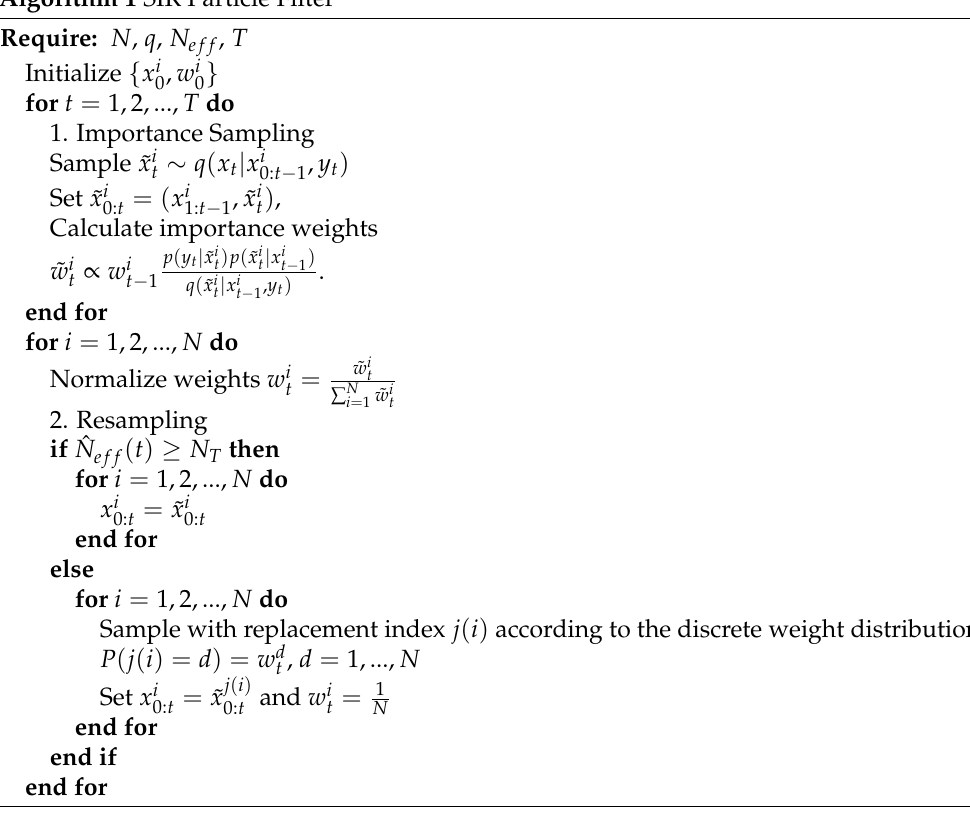
Algorithm 1 SIR Particle